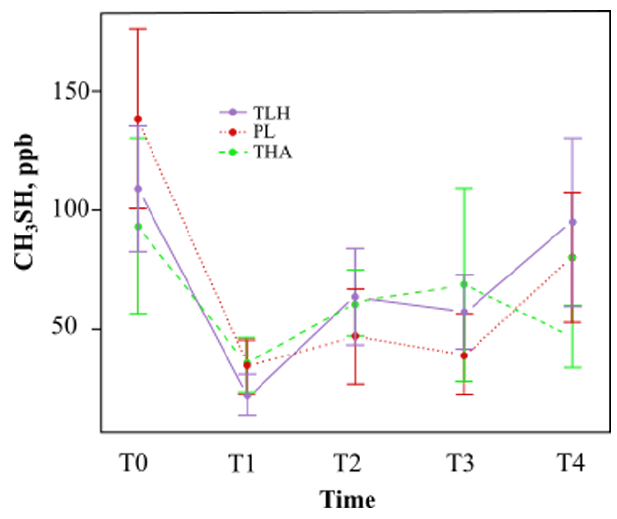
Figure 4. Mean methyl mercaptan concentration (parts per billion) and standard deviation at different times (TLH, Lacer Hali TM treatment; PL, placebo; THA, Halita TM treatment). There were no statistically significant results.